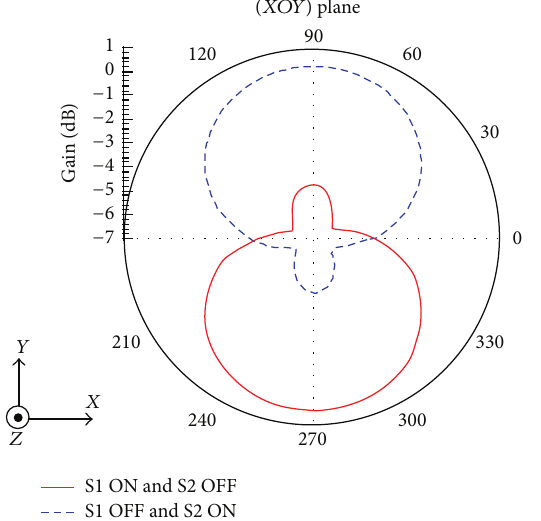
Figure 13: Simulated 2D radiation patterns in the ( 𝑋𝑂𝑌 ) plane of the prototype two-CLL NFRP element reconfigurable antenna at the operating frequency 𝑓 𝑅 = 1.172 GHz.